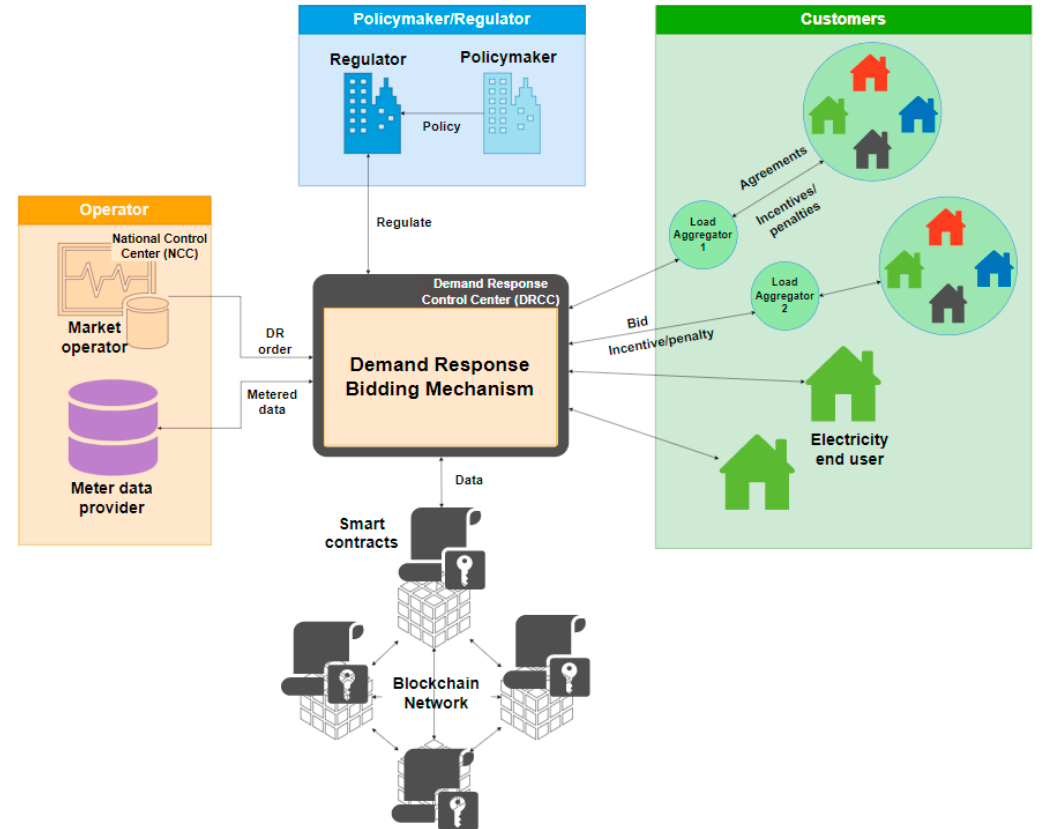
Figure 2. The proposed system architecture.